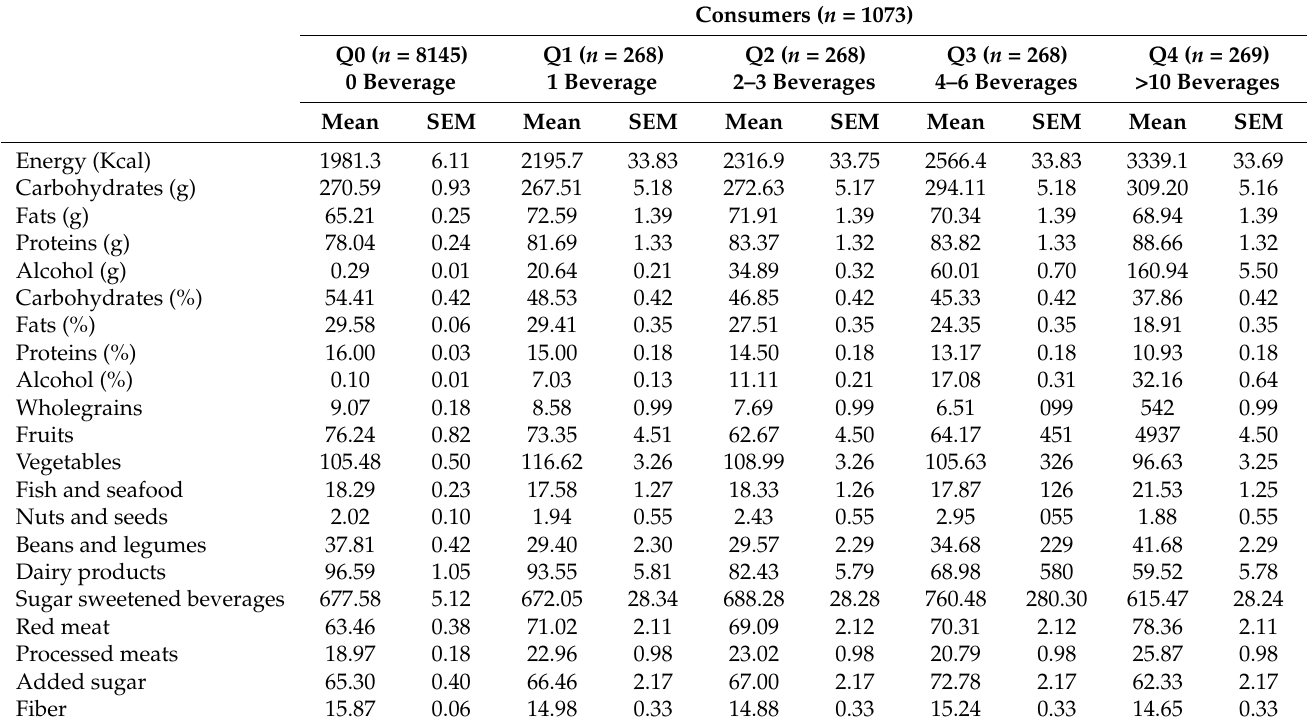
Table 6. Energy, macronutrients, and food groups consumption according to alcohol consumption